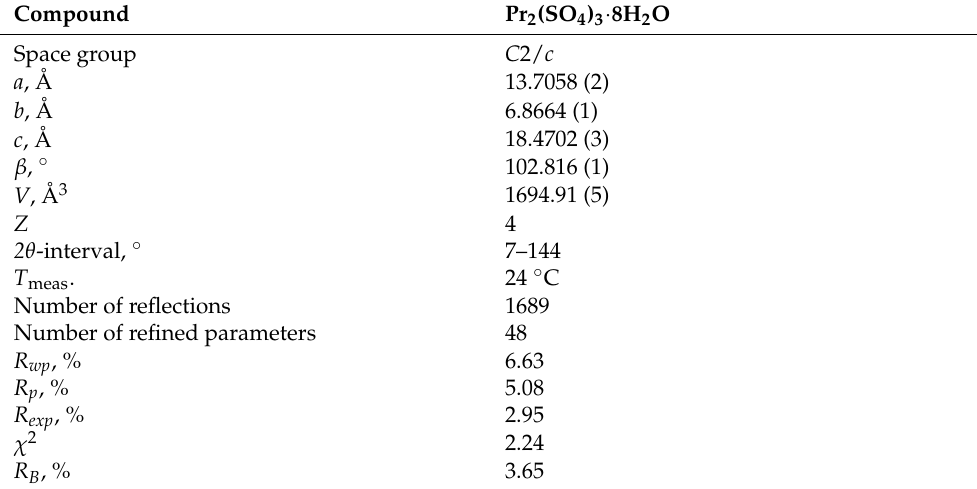
Table 2. Main parameters of processing and refinement of the Pr 2 (SO 4 ) 3 · 8H 2 O